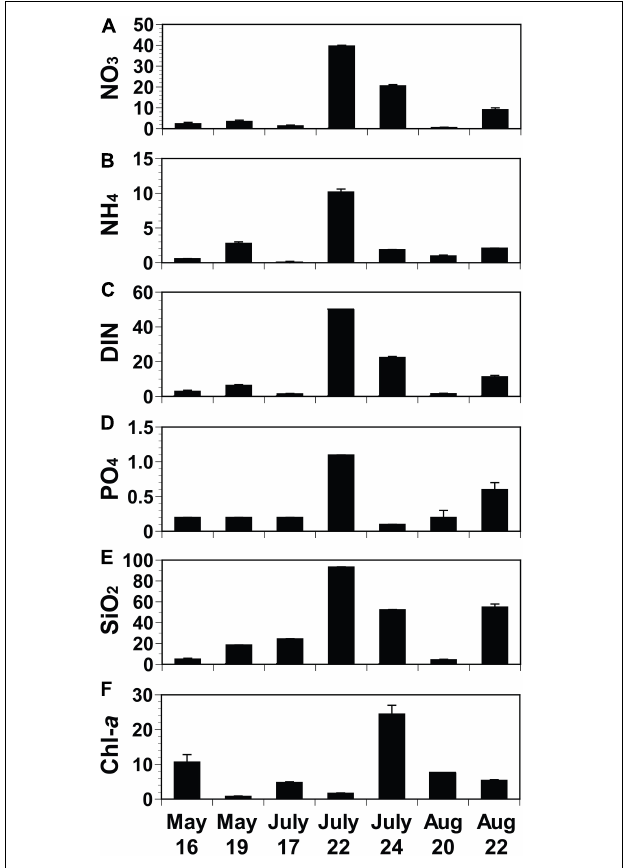
FIGURE 4 | Initial concentrations of nutrients ( A–E ; NO 3 , NH 4 , DIN, PO 4 , and SiO 2 ; µ M) and chlorophyll- a ( F ; Chl- a ; µ g L − 1 ) of each seawater collected from St. Gyedong (August 22) or St. Gukdong (the rest dates) in 2019. Vertical symbols represent treatment means ± 1